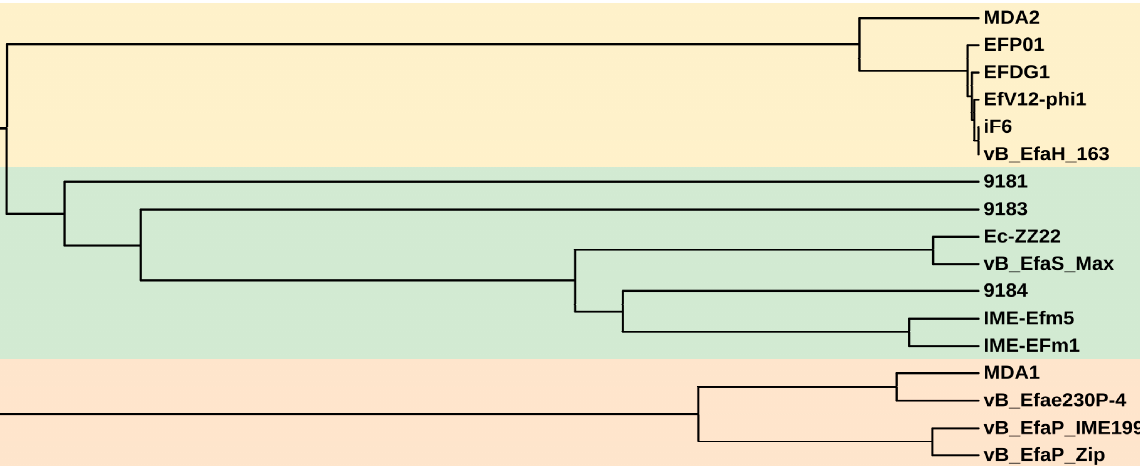
Figure 4. Phylogenetic tree of the E. faecium phages with complete genomes in databases, based on the amino acidic sequence of the major capsid proteins. Light yellow: Herelleviridae phages; light green: Siphoviridae phages; light orange: Podoviridae phages.